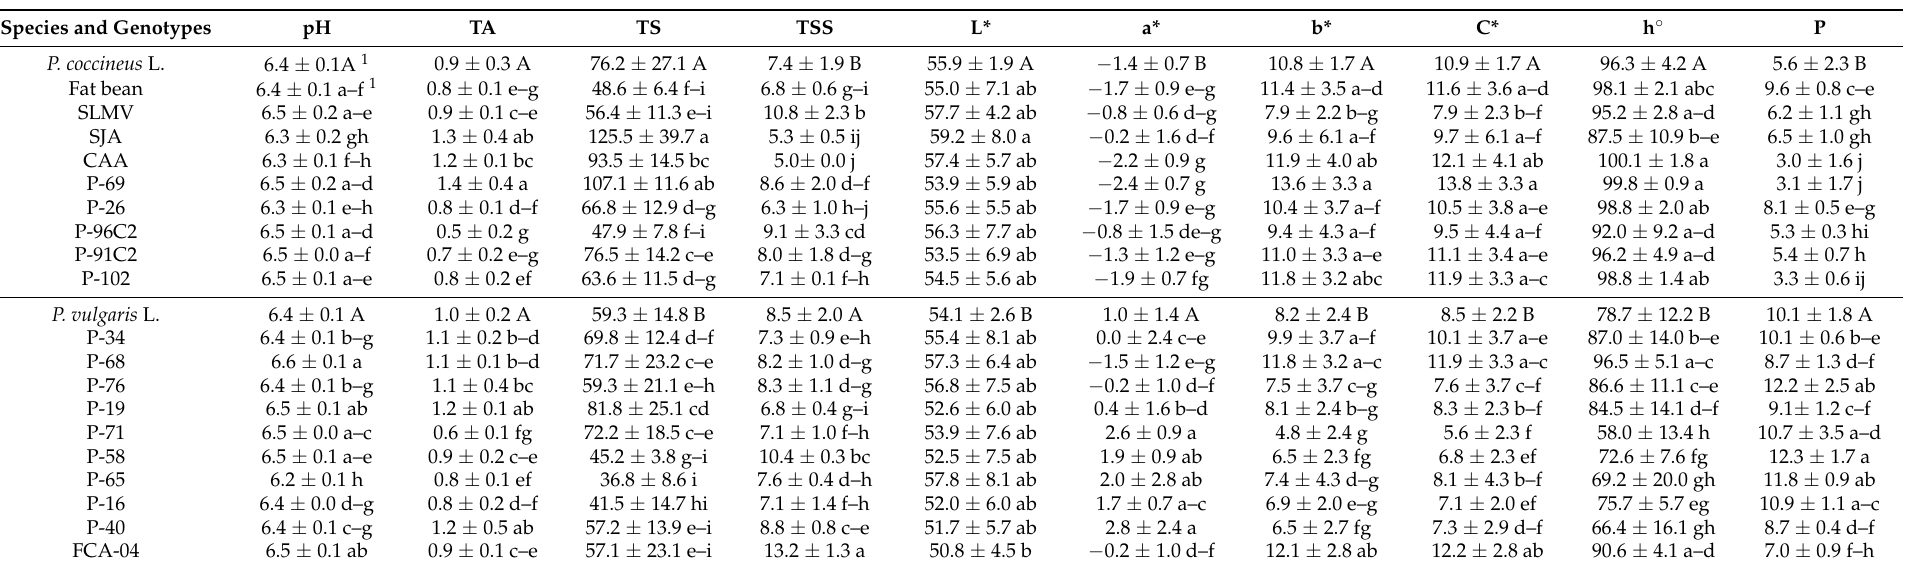
Table 2. Physicochemical, color parameters, and protein content in green beans from bean